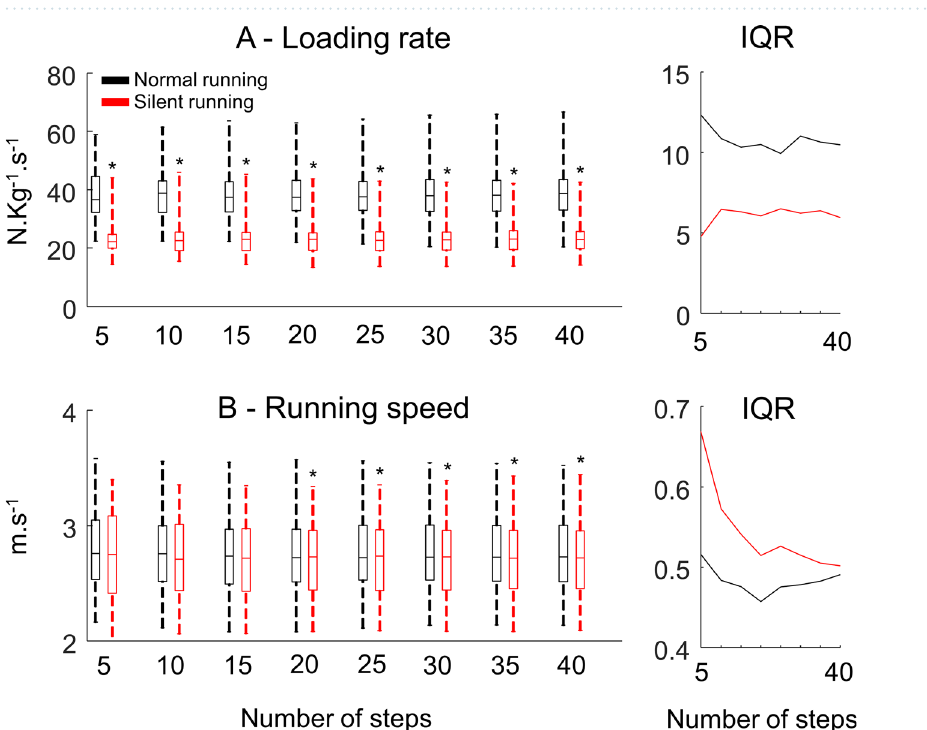
Figure 3. Comparison normal ( black ) versus silent running ( blue ) for vertical loading rate ( A ), and running speed ( B ). Box plots represent 25th and 25th percentiles and data range ( dashed vertical lines ) across different numbers of steps. On the right, interquartile ranges (IQR) across the different number of steps. * denotes a significant difference in relation to normal running ( p <